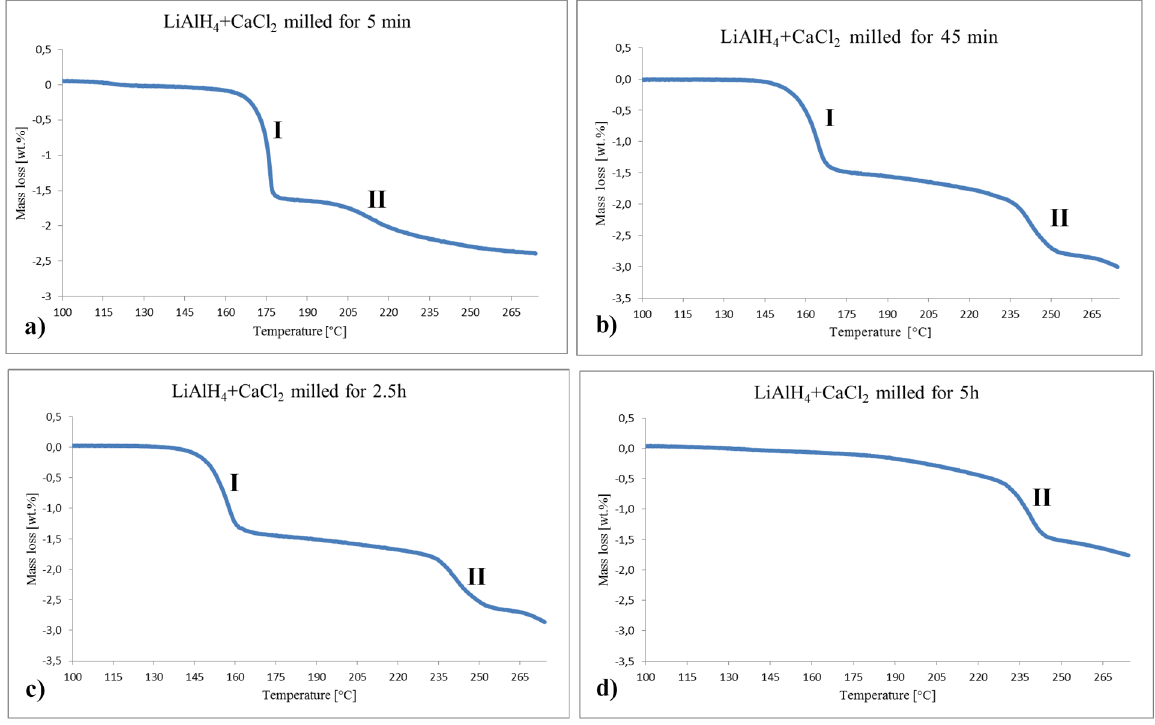
Figure 5. Selected TGA traces for the (2LiAlH 4 +CaCl 2 ) powders after various milling durations. ( a ) 5 min; ( b ) 45 min; ( c ) 2.5 h and ( d ) 5 h. Heating rate 5